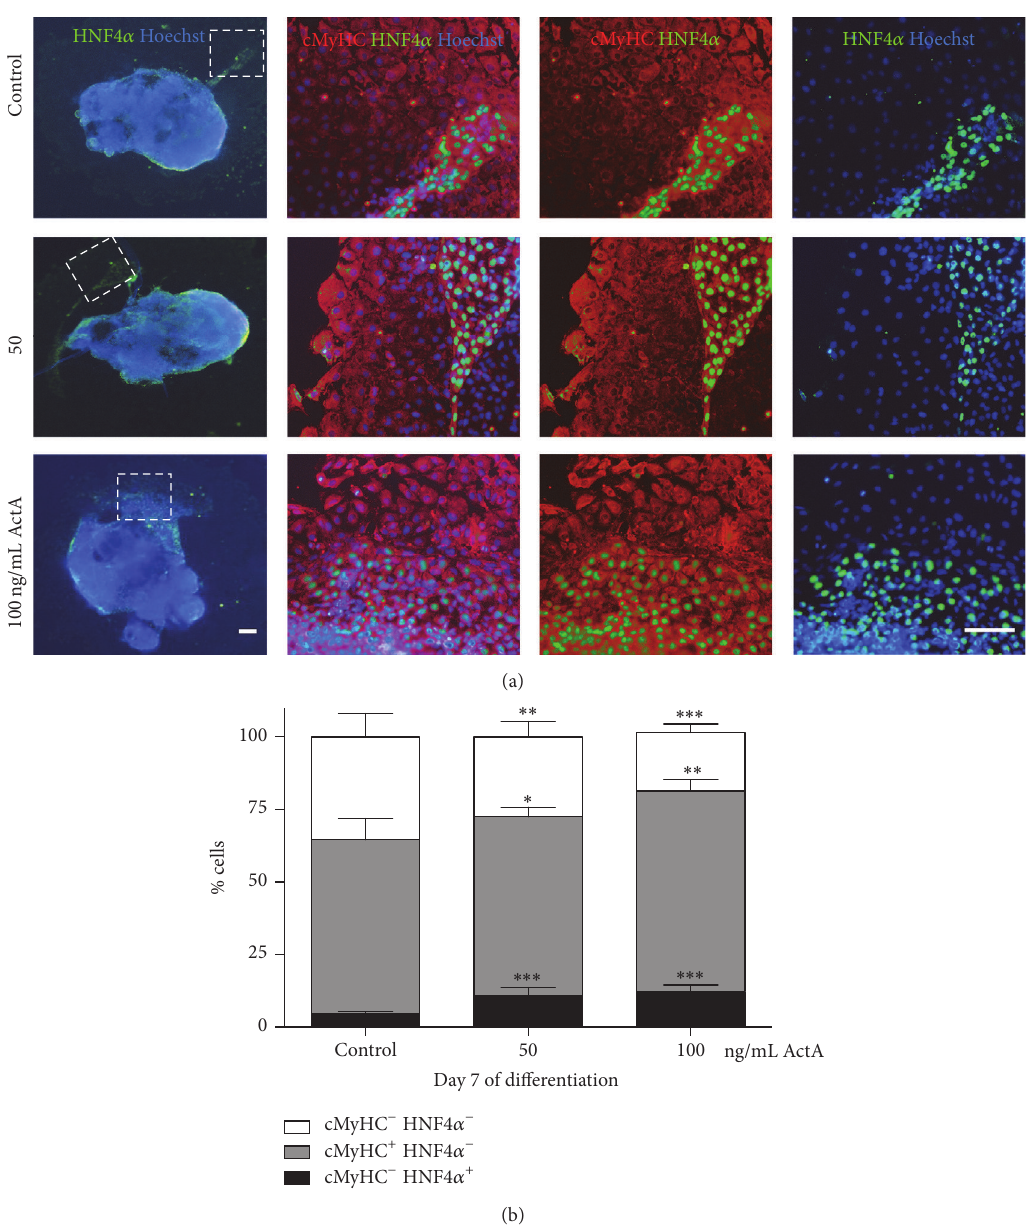
Figure 4: ActA promoted CM differentiation by inducing HNF4 𝛼 + endoderm-like cell population. High doses of 50 and 100ng/mL ActA during the early phases of cardiac differentiation increased the amount of HNF4 𝛼 + endoderm-like cells, which subsequently promoted the CM differentiation efficiency. (a) IF analyses for HNF4 𝛼 (green), cMyHC (red), and Hoechst (blue) in 7-day-old EBs for control and 50 and 100ng/mL ActA treated conditions. Dashed squares indicate the region of interest, corresponding to IF pictures at higher magnification. (b) Quantifications of cMyHC + , HNF4 𝛼 + and cMyHC − HNF4 𝛼 − cell populations in the presence (50 and 100 ng/mL) or absence of ActA are reported as percentages of control conditions. Data are representative of three independent experiments and expressed as mean ± SEM. Significant differences are versus control and indicated as 𝑃 < 0.05 : ∗ ; 𝑃 < 0.01 : ∗∗ ; and 𝑃 < 0.001 : ∗∗∗ . Scale bar = 100 𝜇